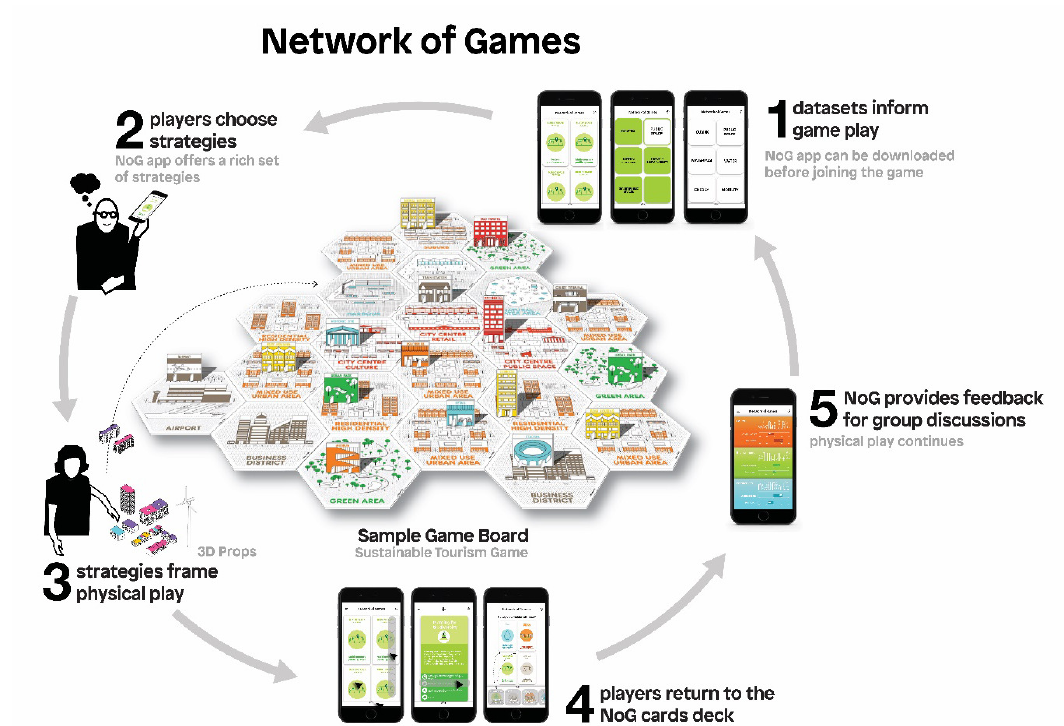
Figure 2. Diagram clarifying the idea behind how city games of various datasets and interfaces can be linked to one